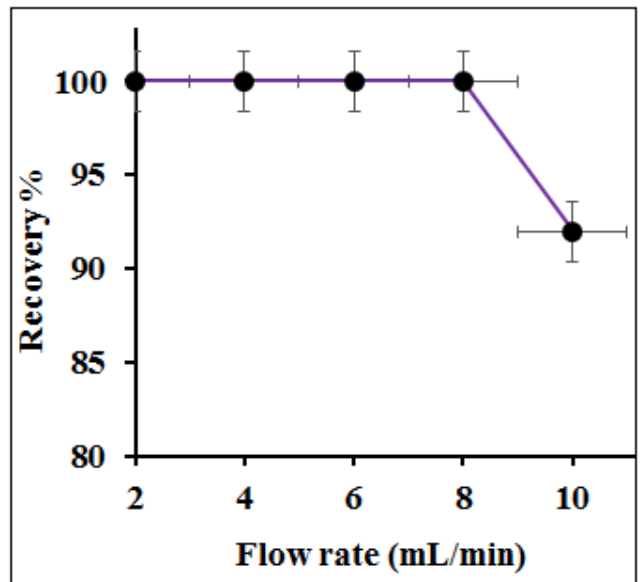
Figure 11. Effect of sample flow on the adsorption of Hg(II) (experimental conditions: sample vol. 100 mL; pH = 6.0; Hg 2 + 10 mg L − 1 ).